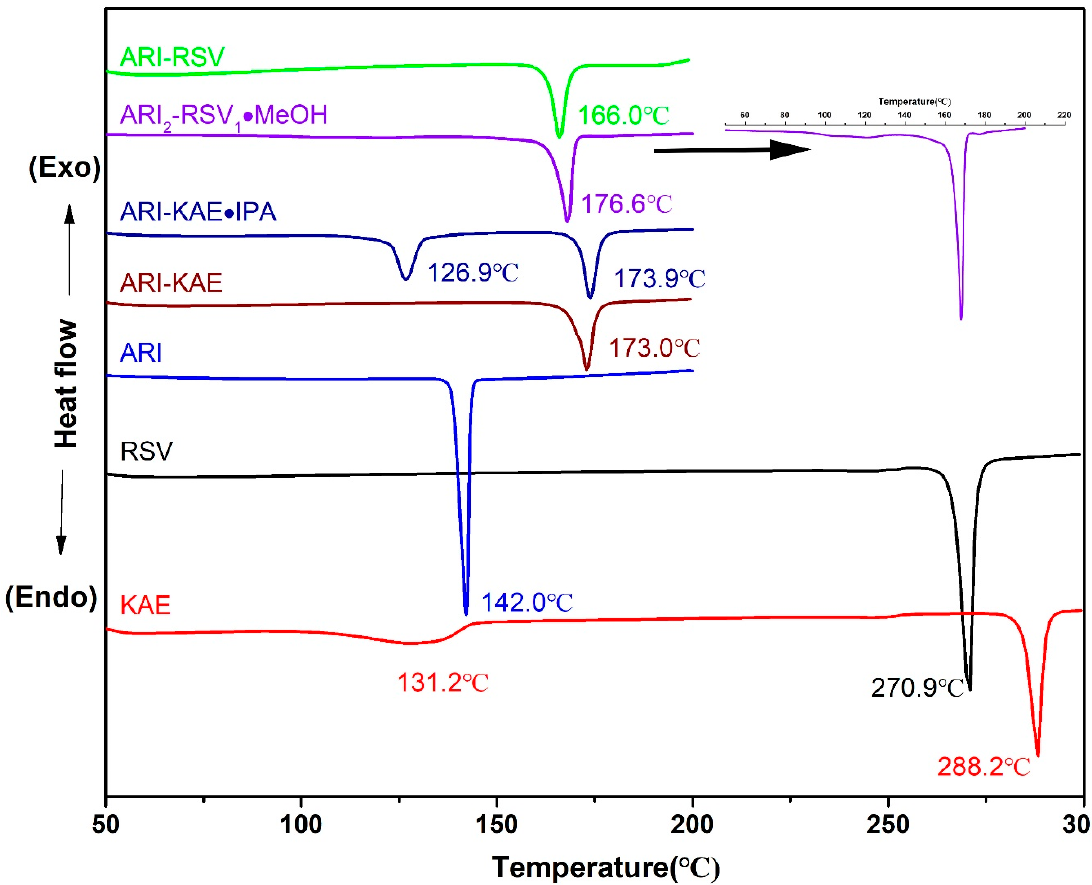
Figure 7. DSC curves of the pharmaceutical cocrystals.